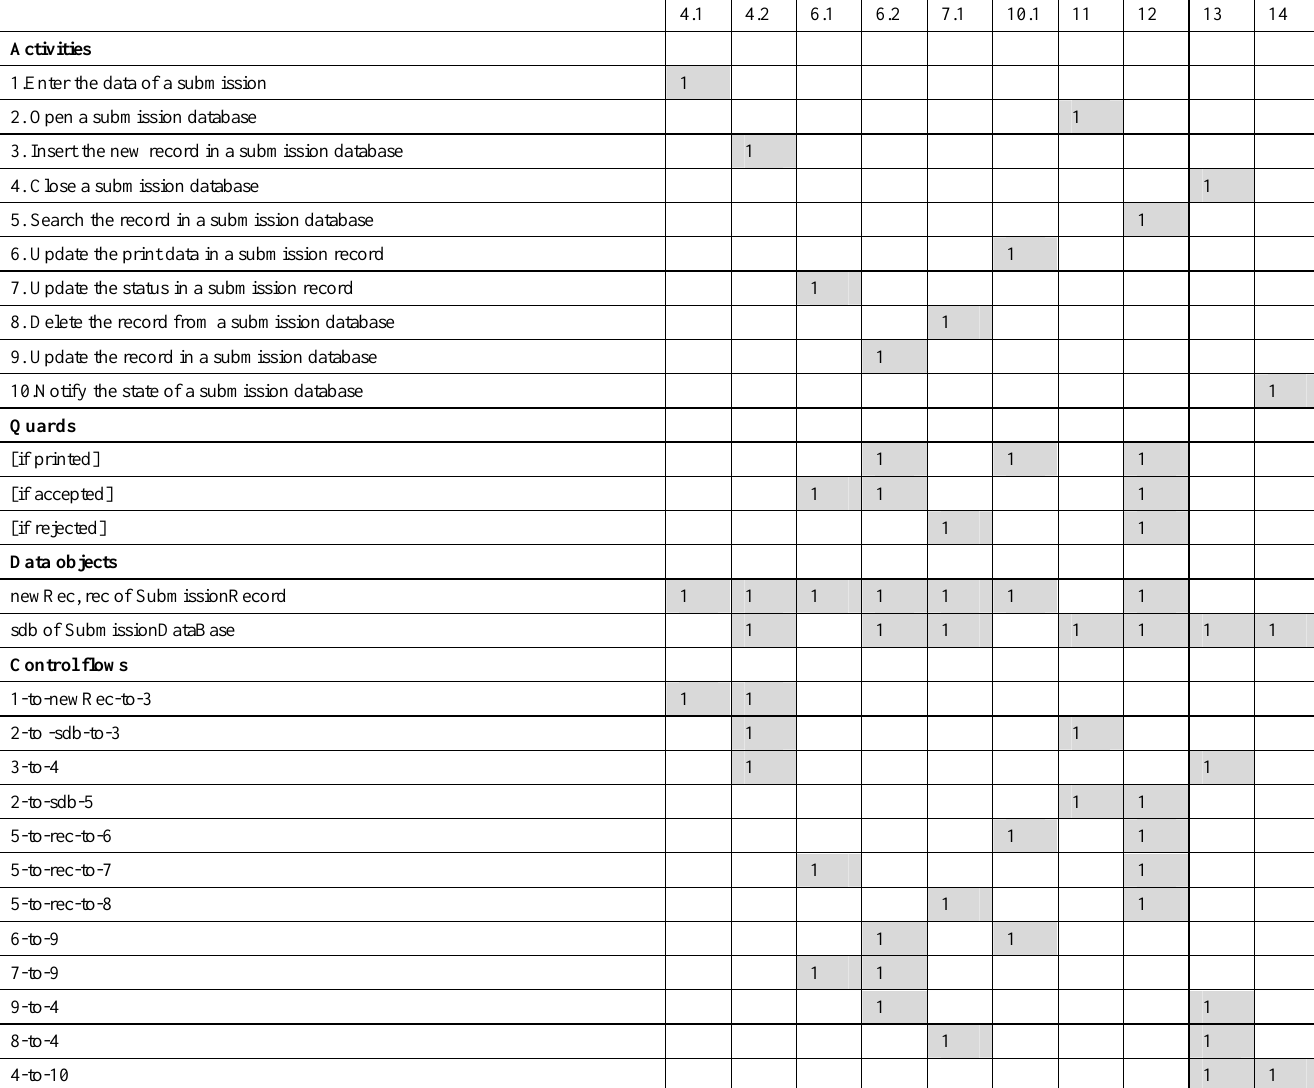
THE TRACEABILITY MATRIX BETWEEN ACTIVITY DIAGRAMS AND THE TFM OF THE SYSTEM “TO